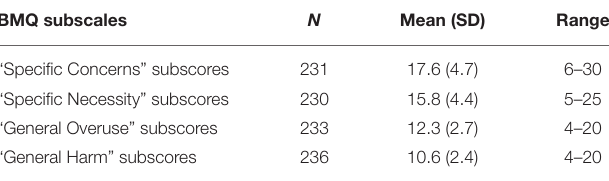
TABLE 2 | Attitudes toward medication as measured by the Beliefs about Medicines Questionnaire (BMQ). BMQ